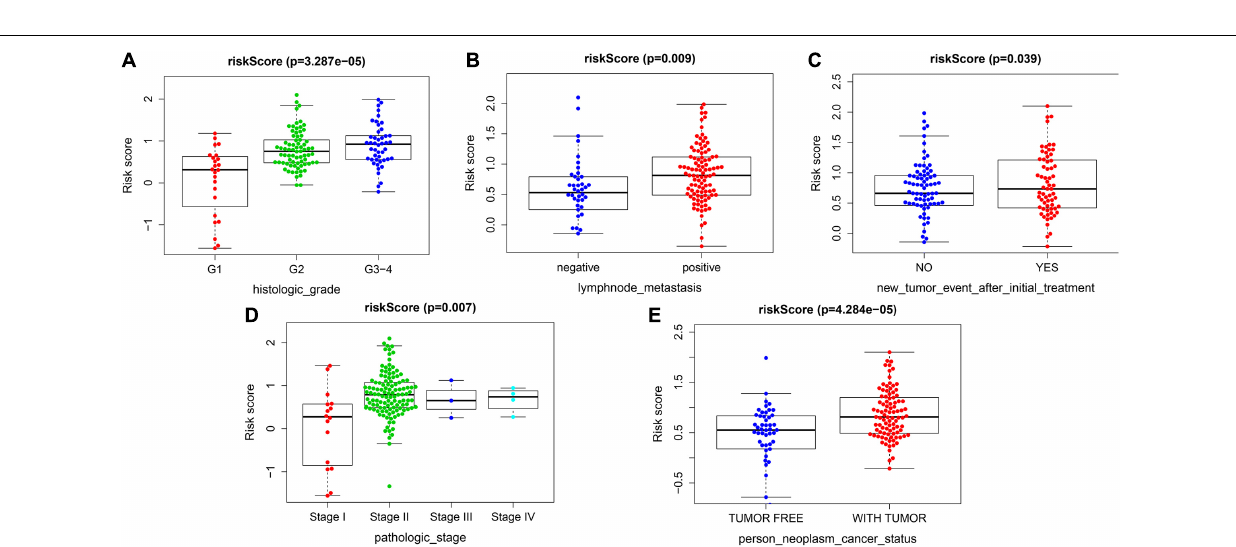
Frontiers in Genetics |